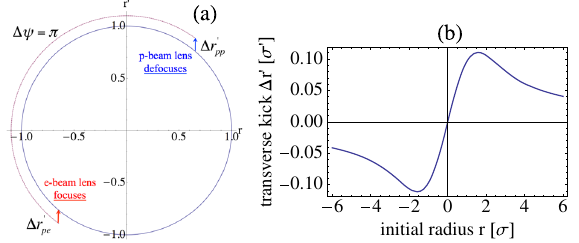
FIG. 1. Reproduced from Ref. [1]. (a) Head-on beam-beam compensation in a phase space view. A defocusing kick Δ r 0 proton receives from the other proton beam is reversed by a focusing kick Δ r 0 from the electron lens after a phase advance π . pe (b) Amplitude dependence of the beam-beam kick Δ r 0 on the radius r [18 –